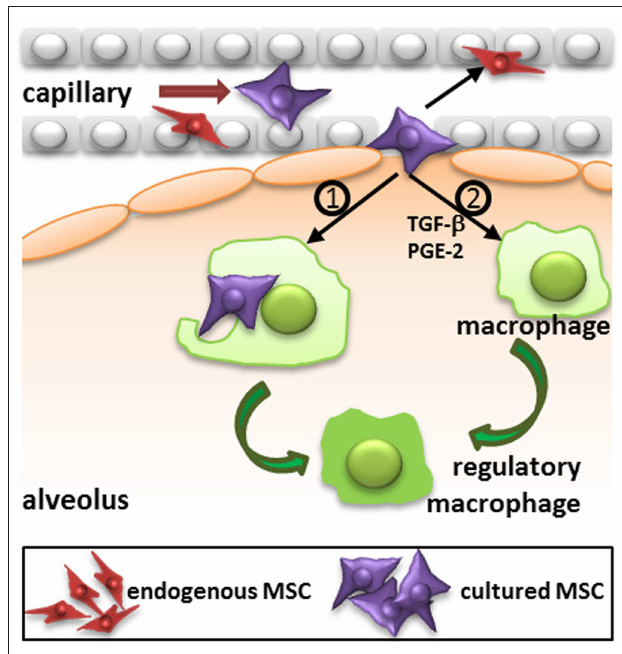
FIgure 2 | proposed mechanism of action of intravenously injected cultured MSc. Administered culture-expanded MSC (large violet cells) target immune cells, including macrophages, and resident progenitor cells, including MSC (small red cells) via their secretome (e.g., TGF- β , PGE-2, and other factors) to stimulate immunomodulatory and regenerative processes. In addition, phagocytosis of MSC by macrophages may induce the formation of regulatory macrophages. TGF- β , transforming growth factor- β ; PGE-2, prostaglandin